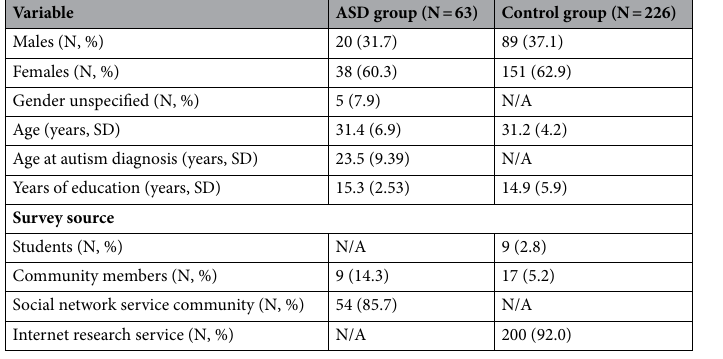
Table 1. Demographic information (N =